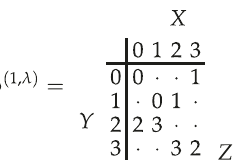
NATURE COMMUNICATIONS | 8: 2086 | DOI: 10.1038/s41467-017-01887-5 |